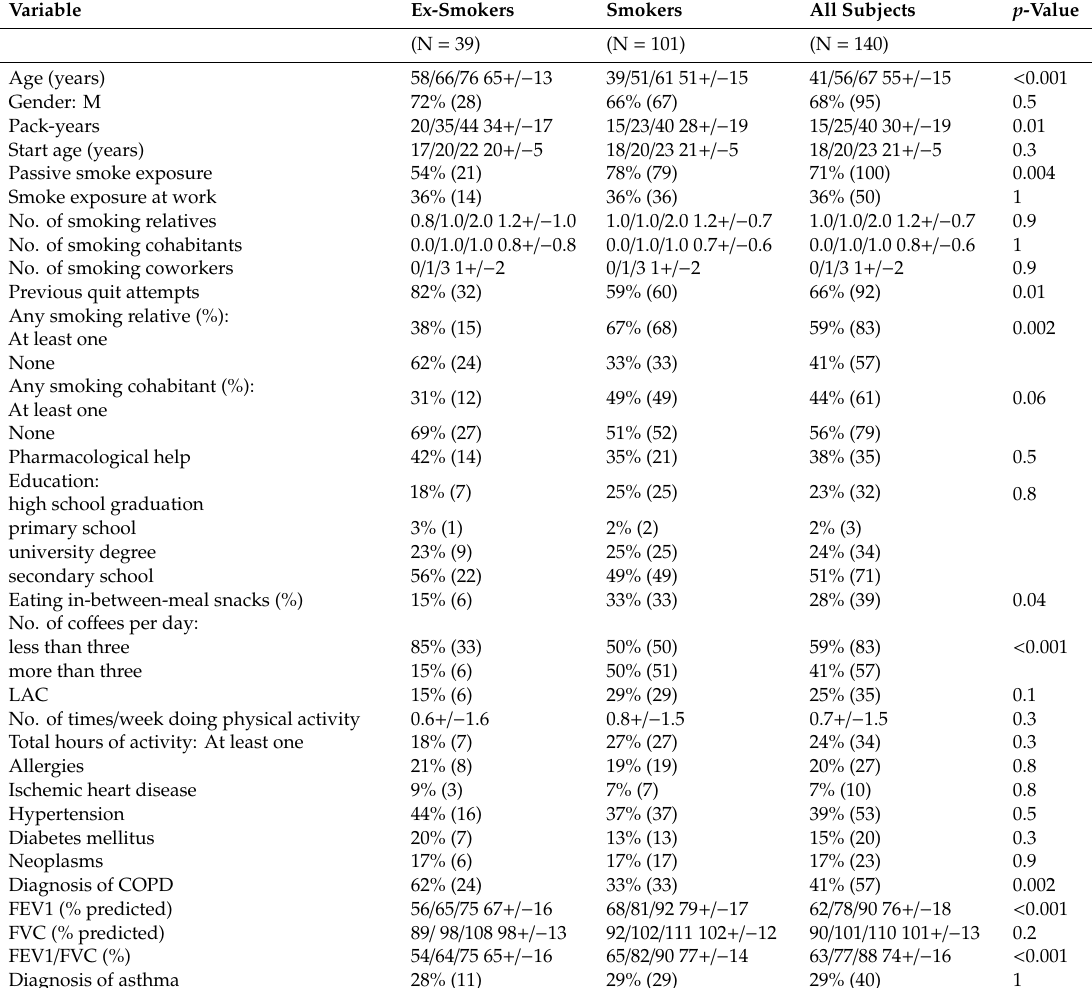
Table 1. Patients’ characteristics according to smoking